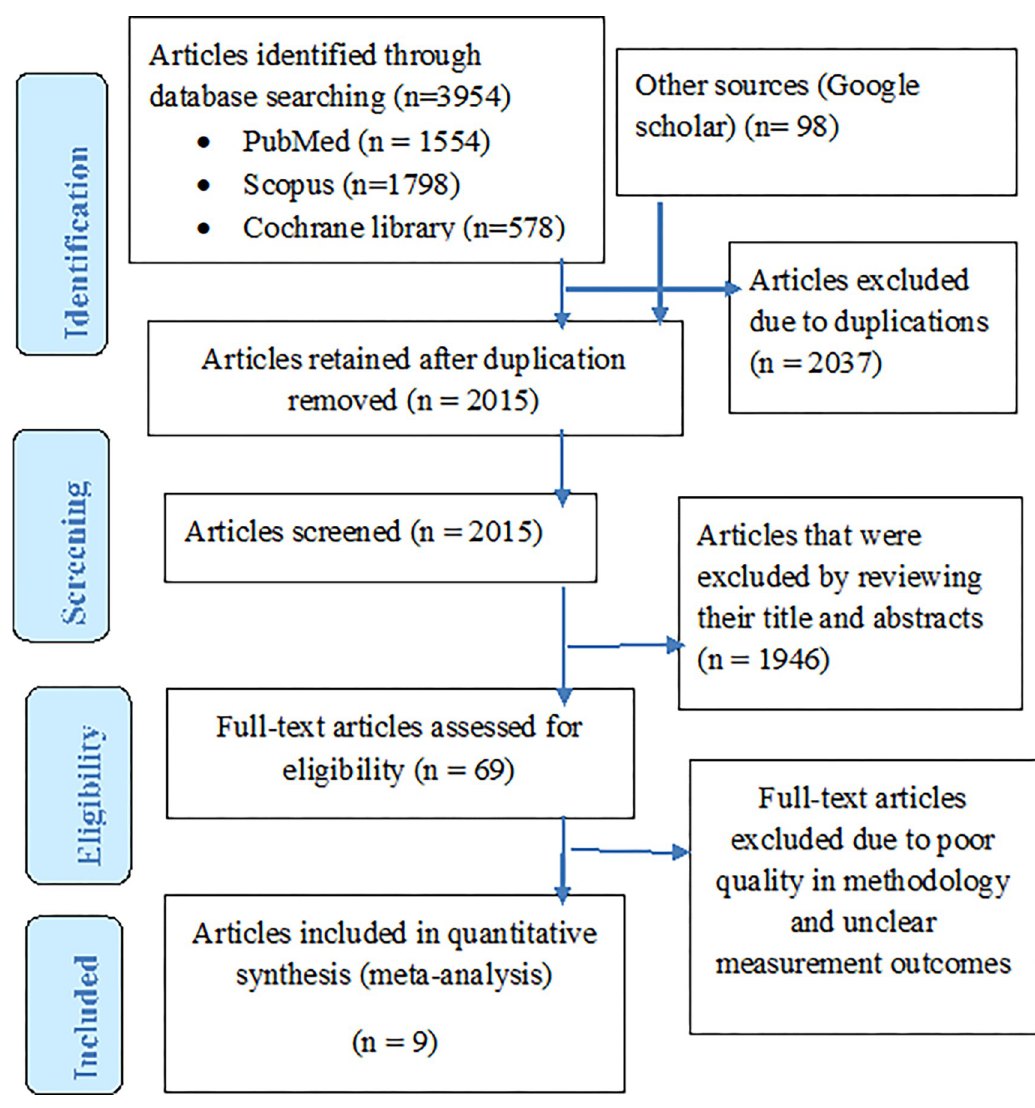
Fig 1. PRISMA flow chart of study